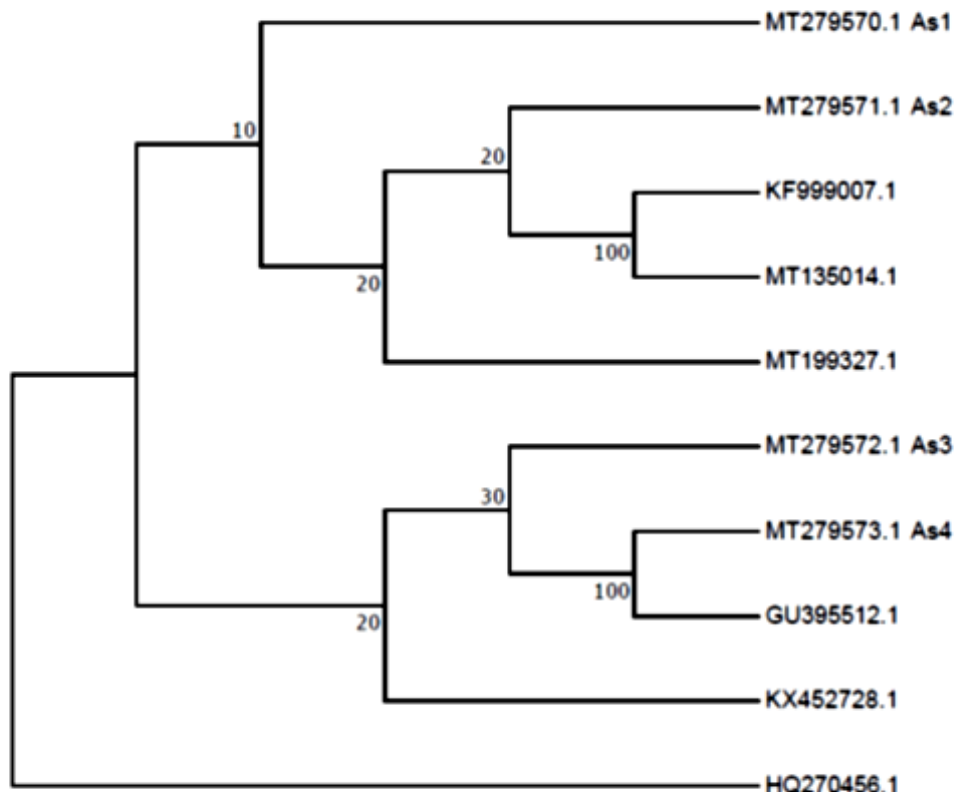
Figure 4. Phylogenetic tree of Alternaria solani isolates (Acc. numbers, MT279570, MT279571, 325 MT279572, and MT279573) obtained in this study compared with ITS sequences by maximum parsimony. A. solani isolates 326 collected from GenBank (Acc. numbers, GU395512, MT135014, KX452728, KF999007, HQ270456 327, and MT199327).